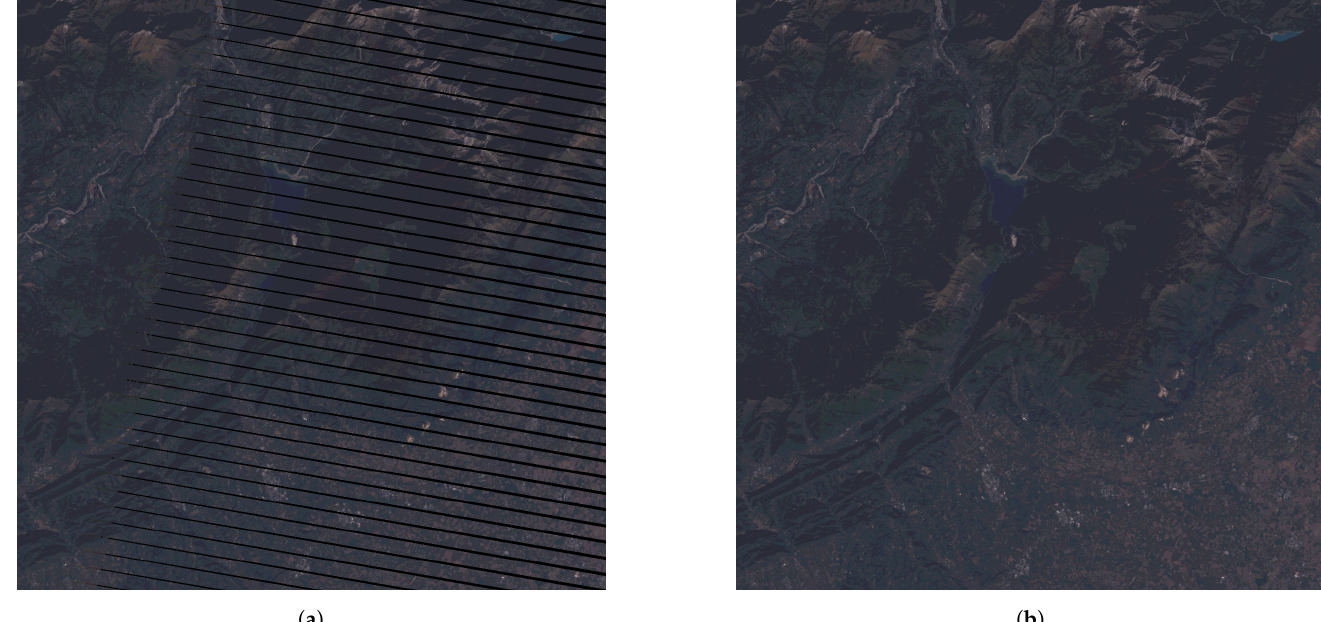
Figure 19. Target and HM reconstruction, see Figure 16. ( a ) target image; ( b ) HM reconstruction.